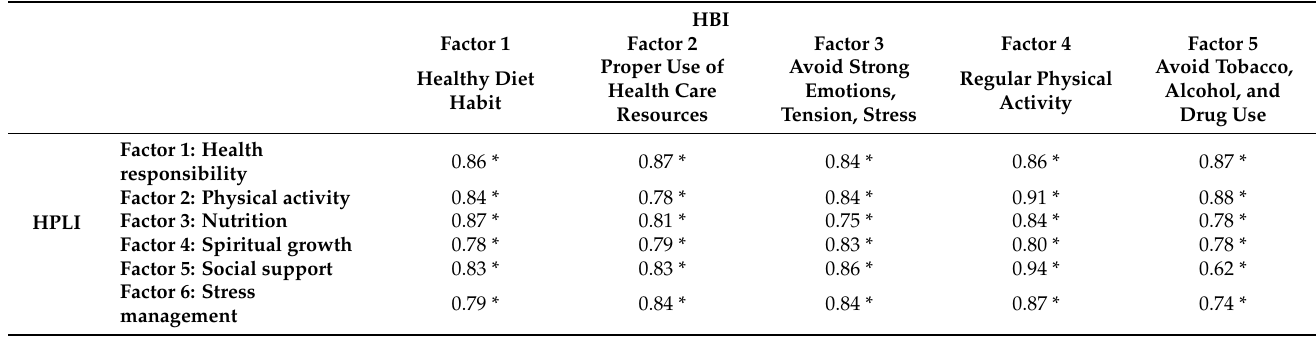
Table 8. Correlation analysis of post-test results of various factors between the HBI and HPLI in females.